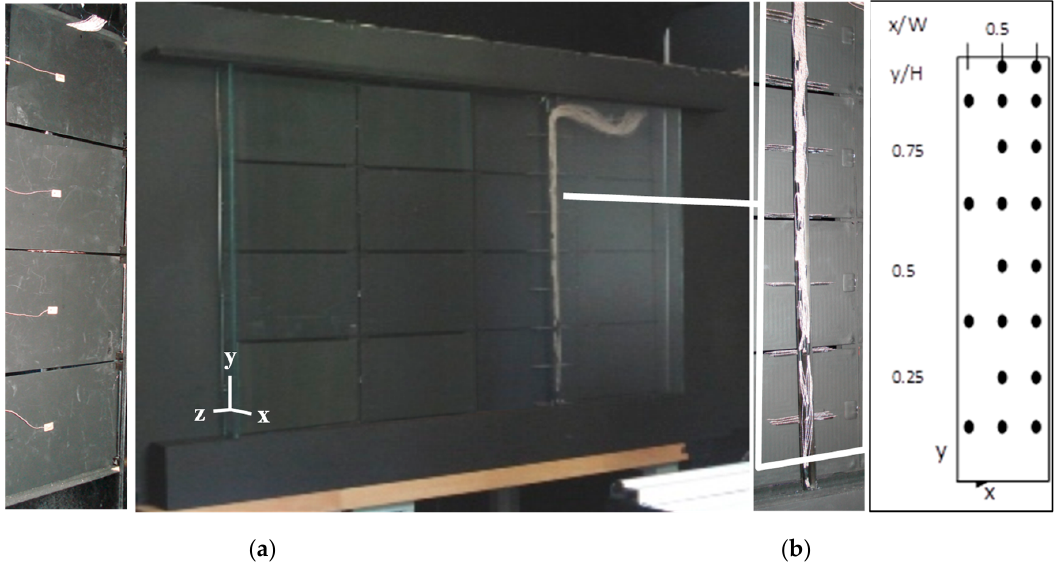
Figure3. Thermalmonitoring: surfacepaneltemperaturesensors( a )andairtemperaturethermocouples location inside the cavity ( b